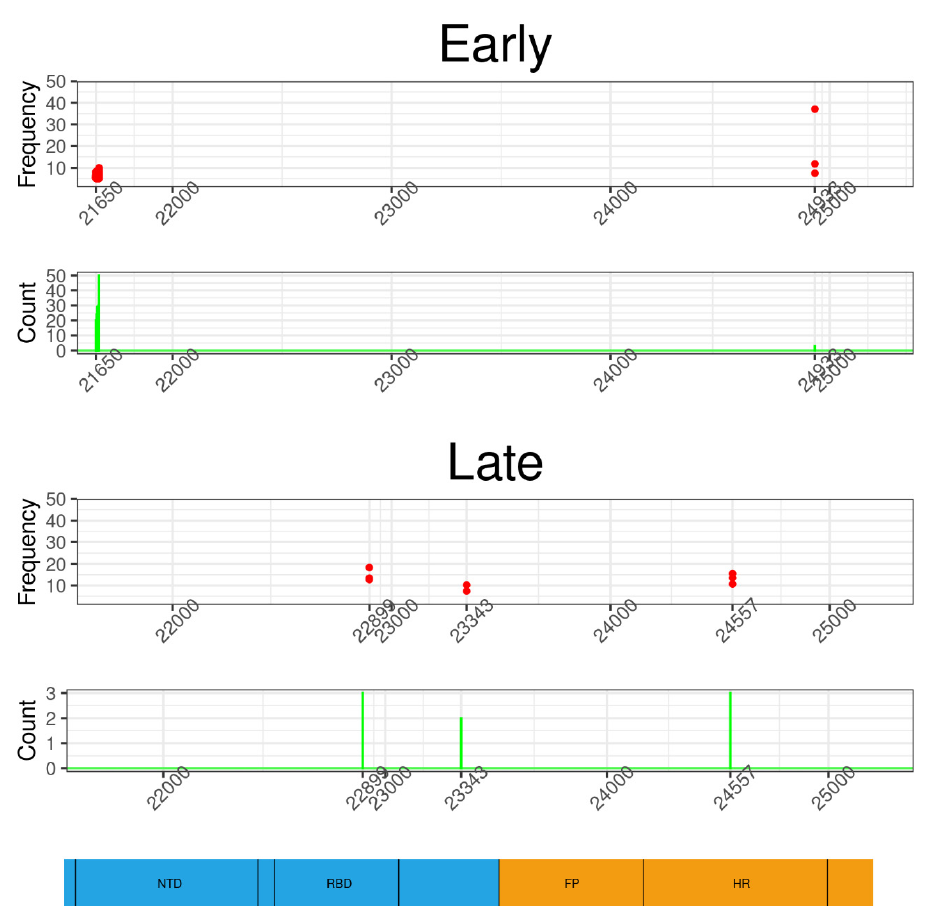
Figure 2. Genomic distribution of nonsynonymous iSNVs of two temporal groups in the S gene. Each dot represents the occurrence and frequency of a specific variant from Early and Late groups. The majority of iSNVs of the Early group are concentrated in a small genomic region starting at position 21,650; they have low intra-host frequencies but are shared by a significant number of samples. The variants of the “Late” group are observed at three positions, one of them localized in the receptor-binding domain (RBD); these mutations have higher frequencies but are shared by a small number of samples. The bottom of the figure shows a schematic representation of the S gene and its main domains: N-terminal do- main (NTD), receptor-binding domain (RBD), fusion peptide (FP), heptad repeat (HR).